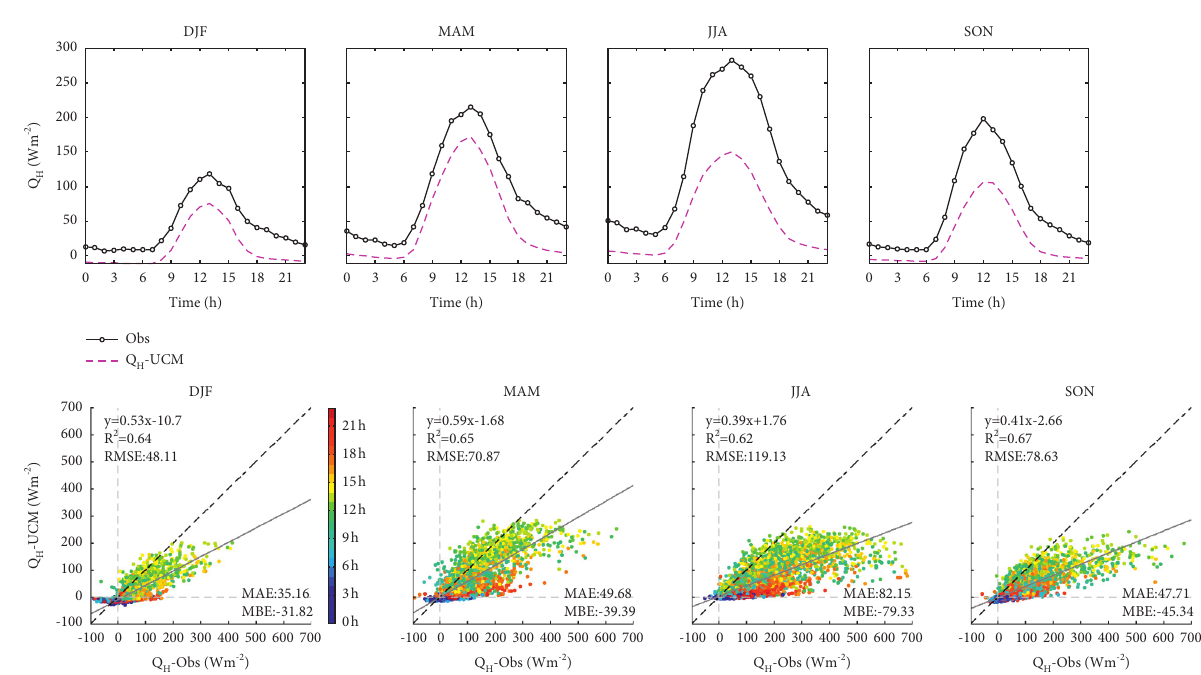
Figure 6: The same as Figure 3, but for the sensible heat flux ( Q